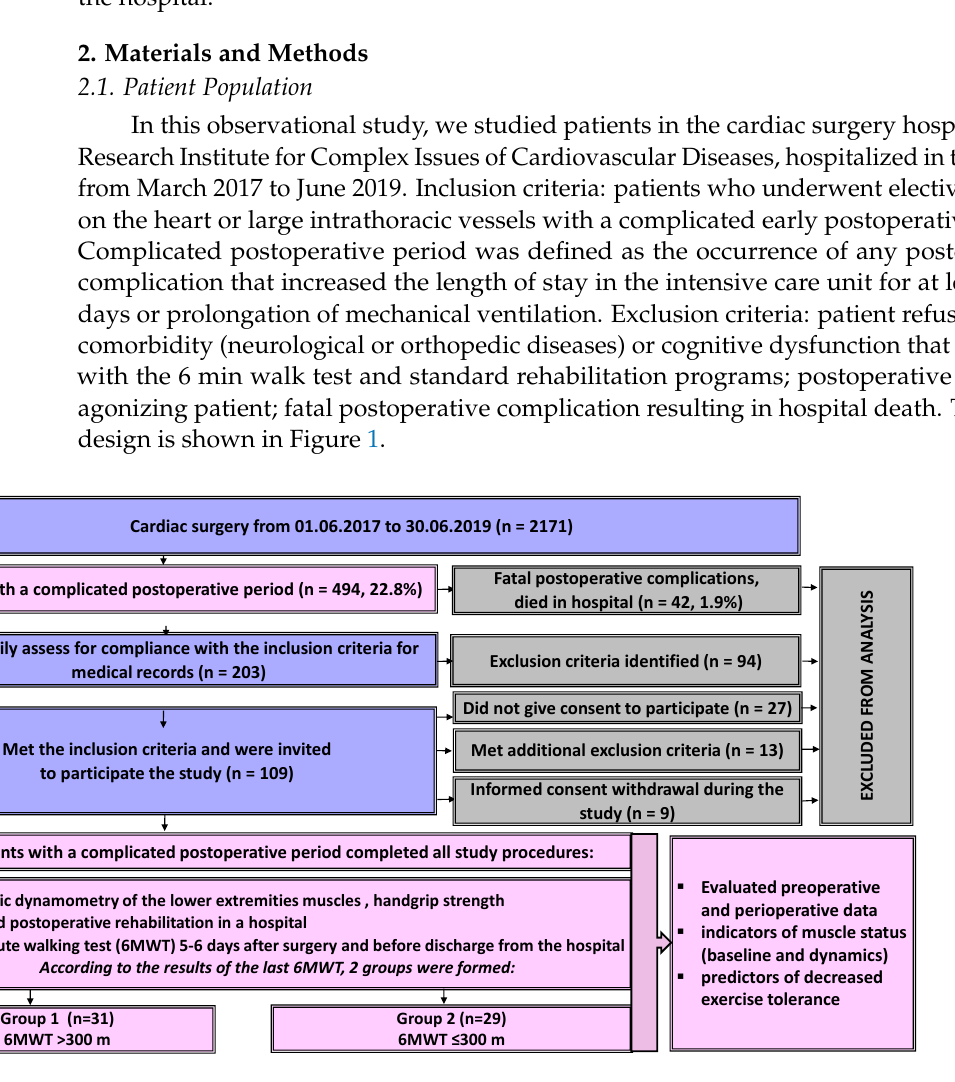
Figure 1. Study design. Patient selection and inclusion